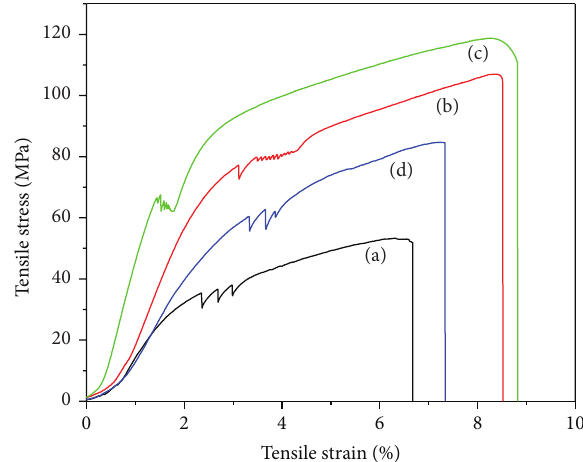
Figure 6: DSC of films, (a) virgin fibers, (b) AmimCl, (c) BmimCl, (d) EmimCl, and (e) EmimAc.